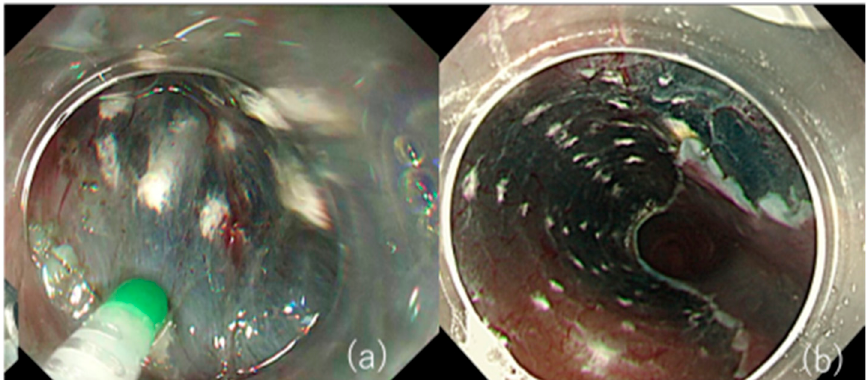
Figure 3. Safe local injection of TA with a spraying tube. ( a ) A spraying tube with a dull tip can be used for safe local injection by simply pushing against the submucosal loose tissue. ( b ) TA is evenly injected into the ulcer bed of esophageal ESD.